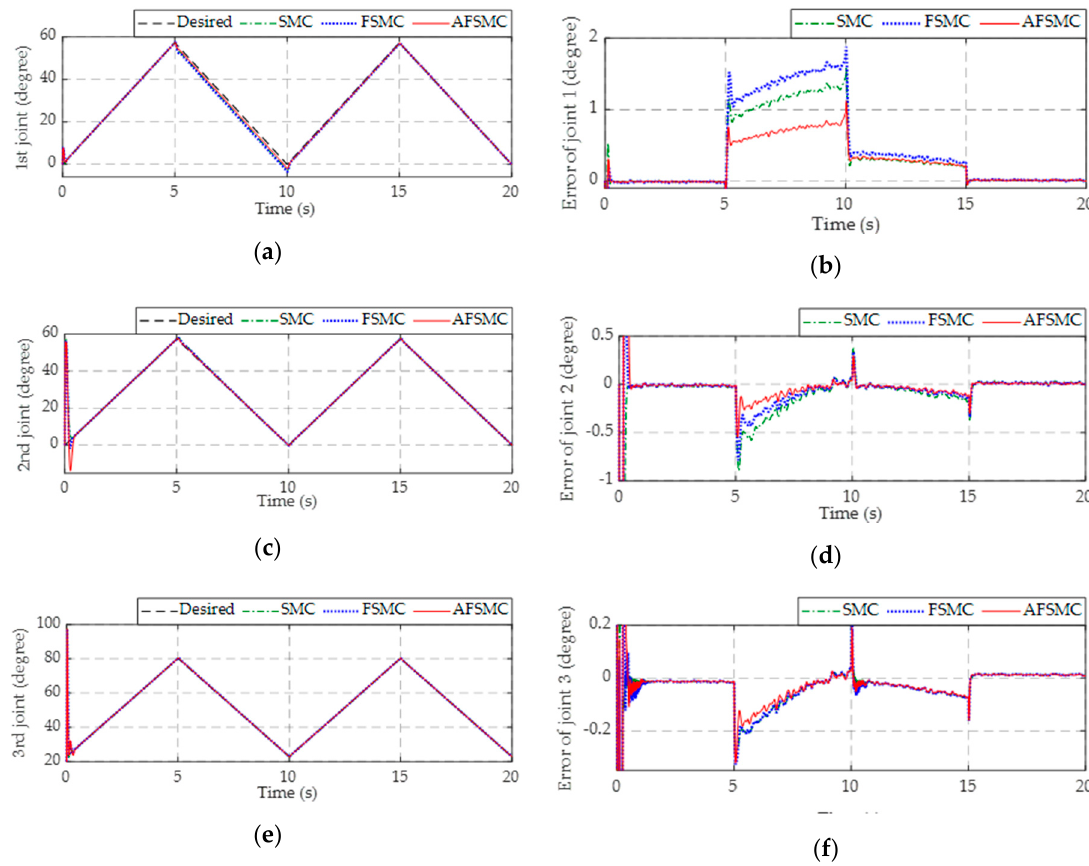
Figure 10. The tracking performance of the three joints: ( a ) The first joint and ( b ) its error; ( c ) the second joint and ( d ) its error; ( e ) the third joint and ( f ) its error when applying sliding mode control (SMC), fuzzy sliding mode control (FSMC), and adaptive fuzzy sliding mode control (AFSMC).